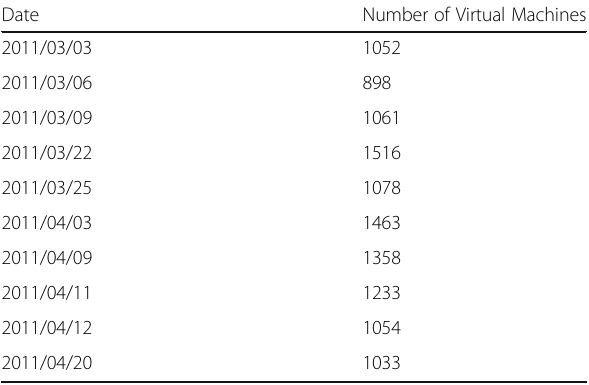
Table 3 Characteristics of workload